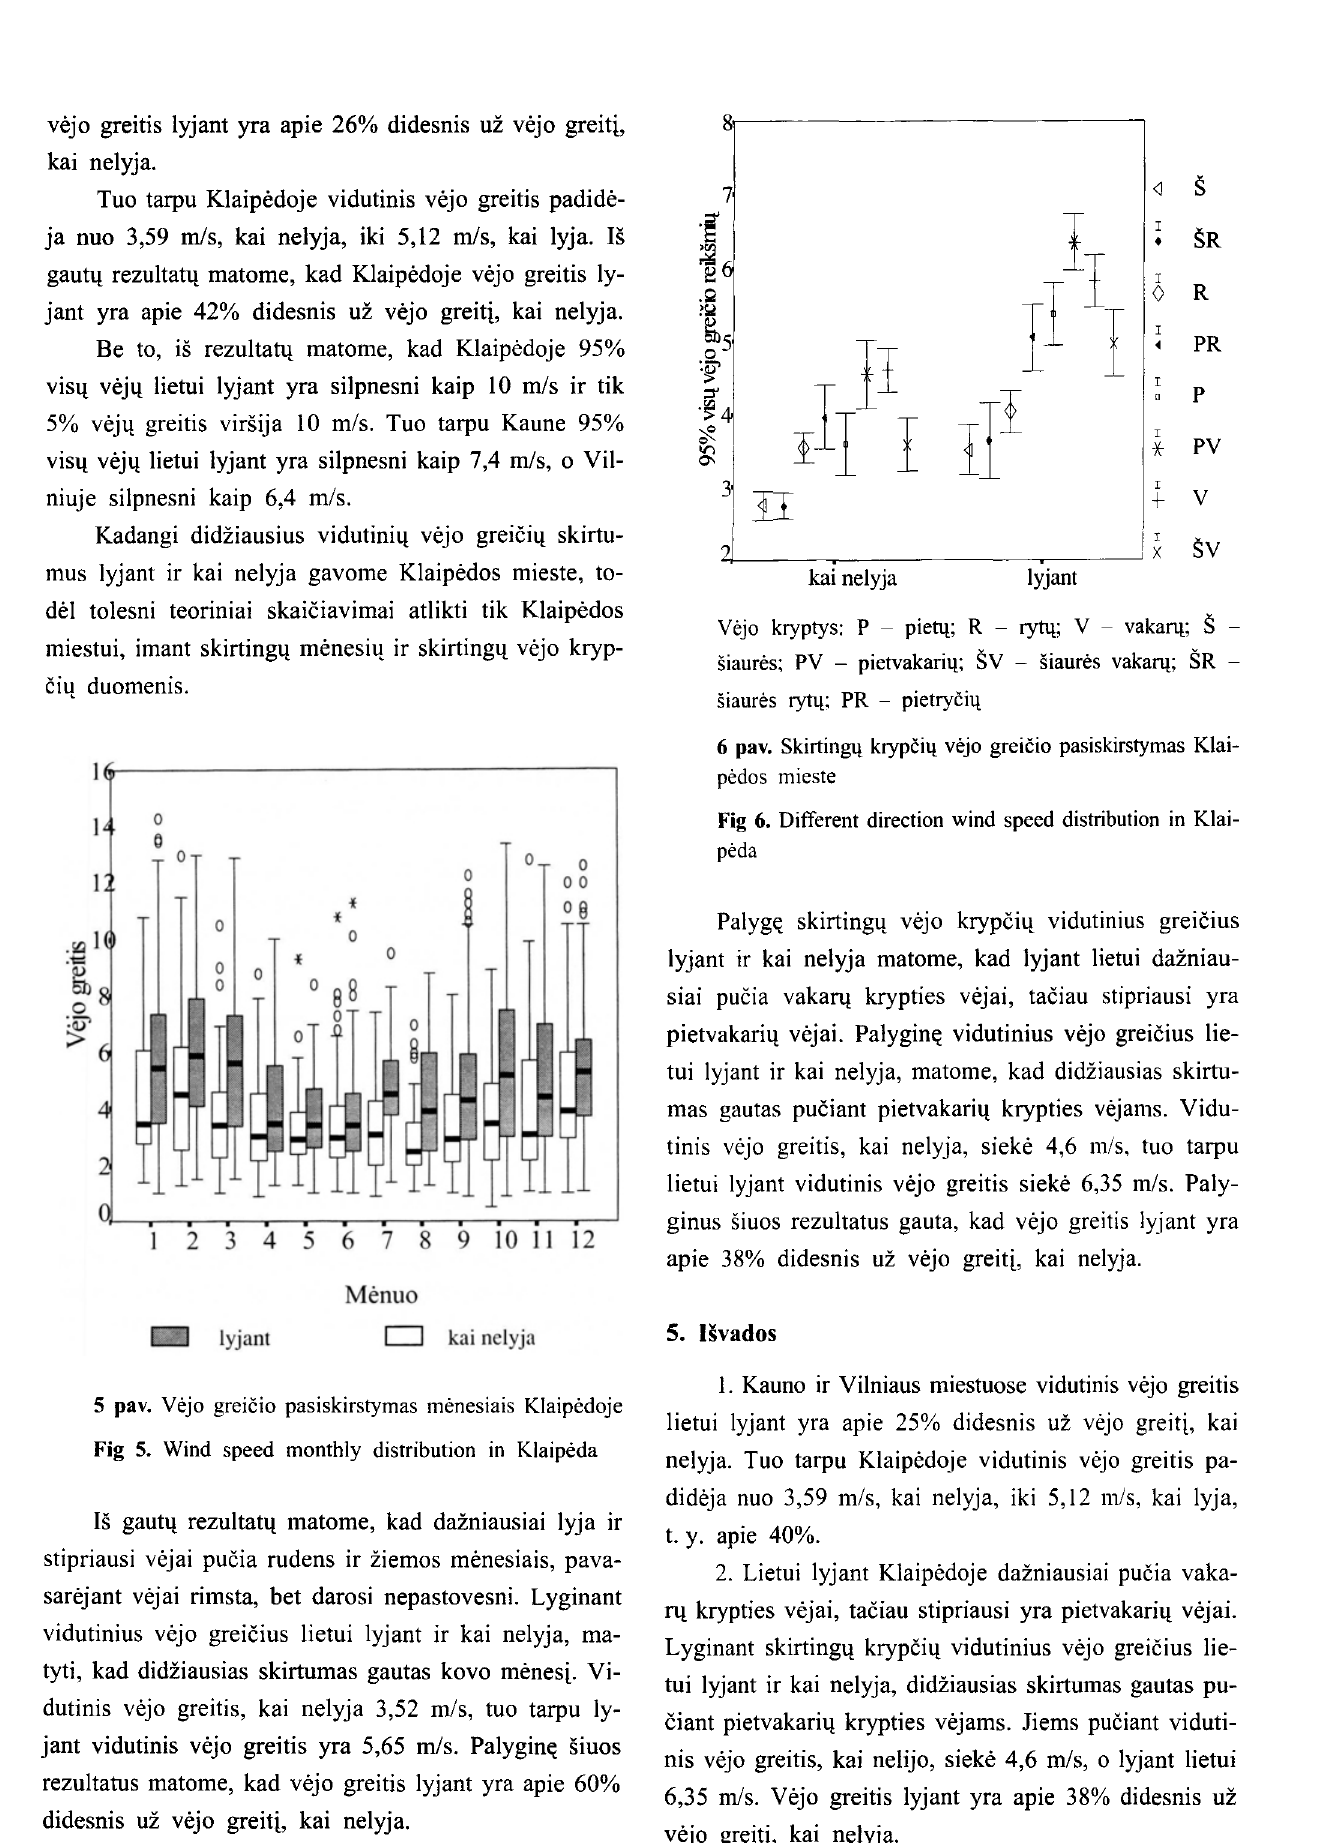
vejo greitis lyjant yra apie 26% didesnis uz vejo greiti, kai nelyja. Tuo tarpu Klaipedoje vidutinis vejo greitis padide ja nuo 3,59 m/s, kai nelyja, iki 5,12 m/s, kai lyja. IS gautq rezultatq matome, kad Klaipedoje vejo greitis ly jant yra apie 42% didesnis uz vejo greiti, kai nelyja. Be to, is rezultatq matome, kad Klaipedoje 95%